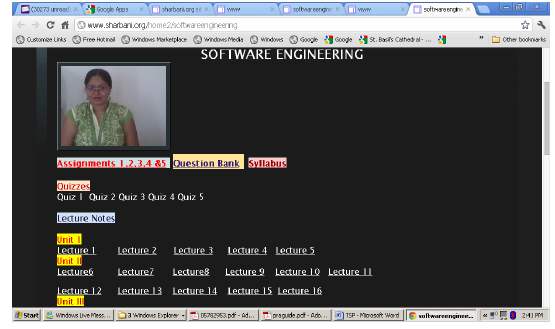
Figure 1. Question Banks, Quizzes & Syllabus